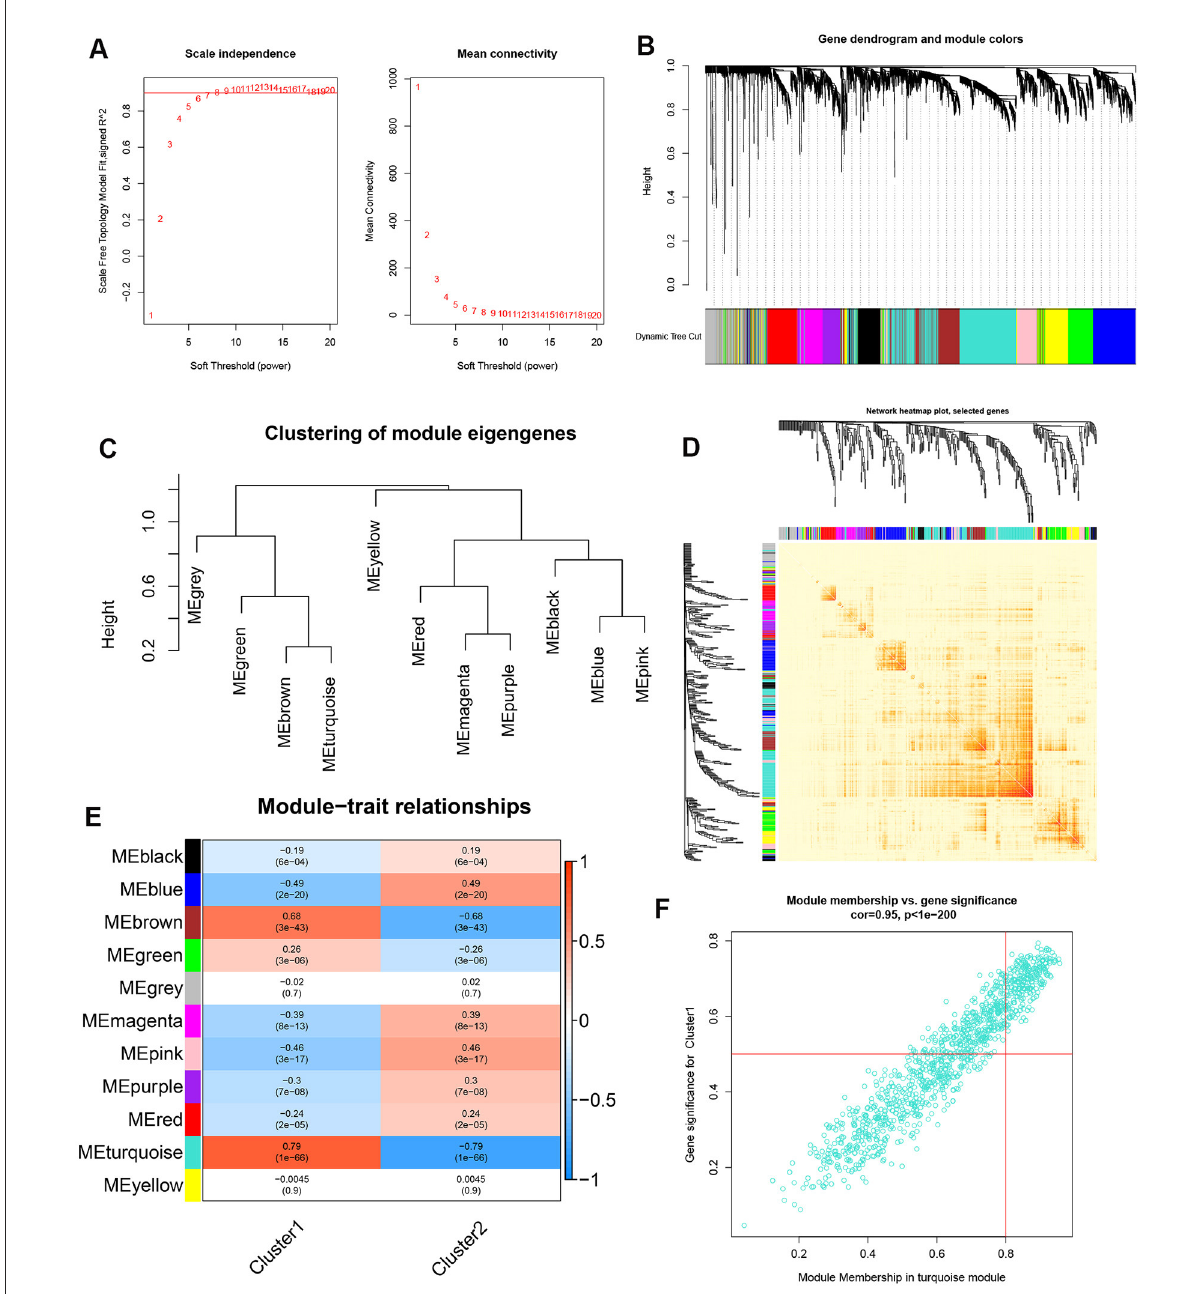
FIGURE6 Co-expression network of differentially expressed genes between the two cuproptosis clusters. (A) The selection of soft threshold power. (B) Cluster tree dendrogram of co-expression modules. Different colors represent distinct co-expression modules. (C) Representative of clustering of module eigengenes. (D) Representative heatmap of the correlations among 11 modules. (E) Correlation analysis between module eigengenes and clinical status. Each row represents a module; each column represents a clinical status. (F) Scatter plot between module membership in turquoise module and the gene significance for